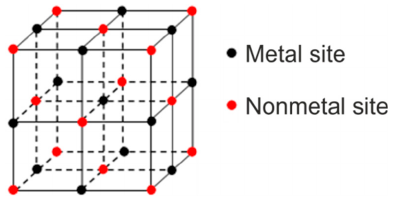
Figure 1. Schematic sketch showing the lattice structure of the MX phase.